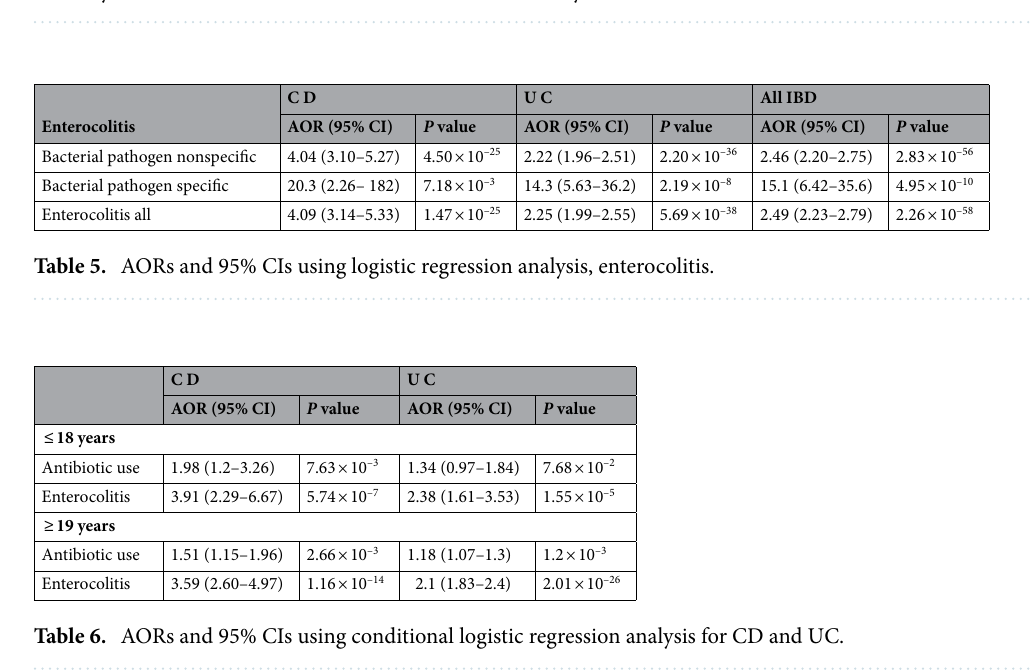
Table 4. AORs and 95% CIs using logistic regression analysis, antibiotic type prescribed. a Trimethoprim/ Sulfamethoxazole. b Amphotericin, Imidazole, and Triazole. c Metronidazole, Glycopeptide, Polymixin, Fosfomycin, Linezolid, Fidaxomicin, Rifaximin, and Anti-mycobacterials.